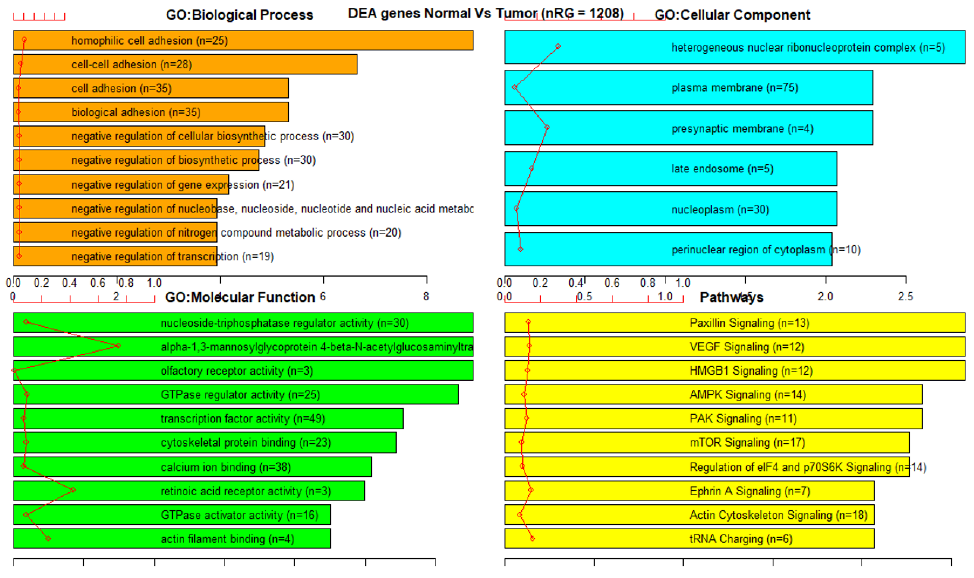
Figure A4. Gene Set Enrichment Analysis on reduced markers of 450K without